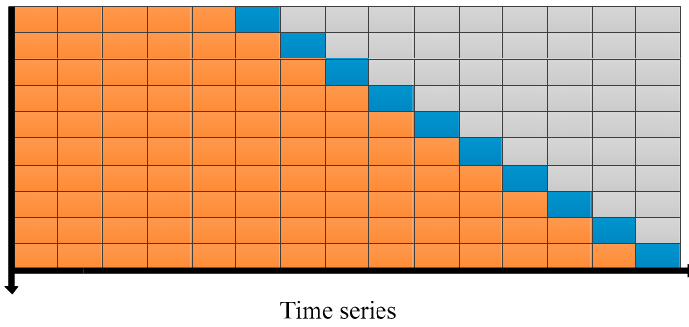
Figure 8. The blue block represents the test set and the orange block represents the training set.